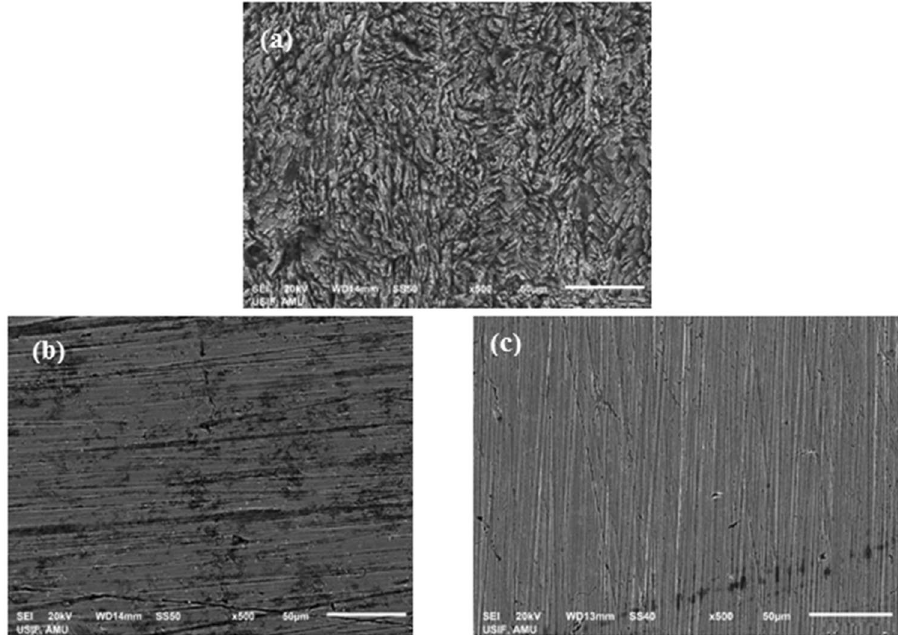
Figure 14. SEM images of the MS after 6 h immersion in 1M HCl solution: ( a ) in 1M HCl, ( b ) in 1M HCl solution with LPr ( c ) in 1M HCl solution with LPr + 10 ppm